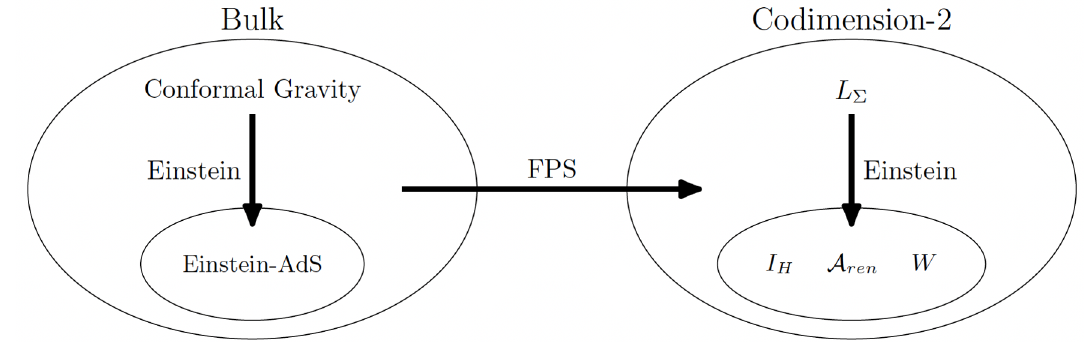
Figure 1 . Diagram showing the relations between the functionals discussed in the